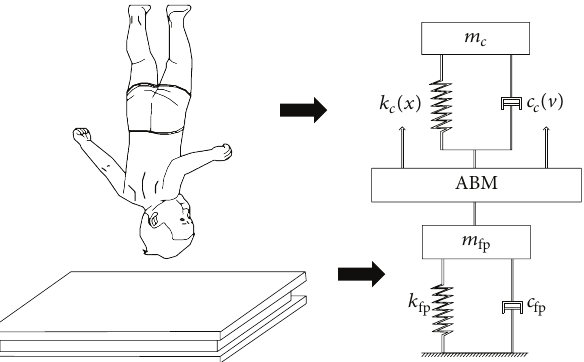
Figure 2: Envelope of the 50 measured impact forces.